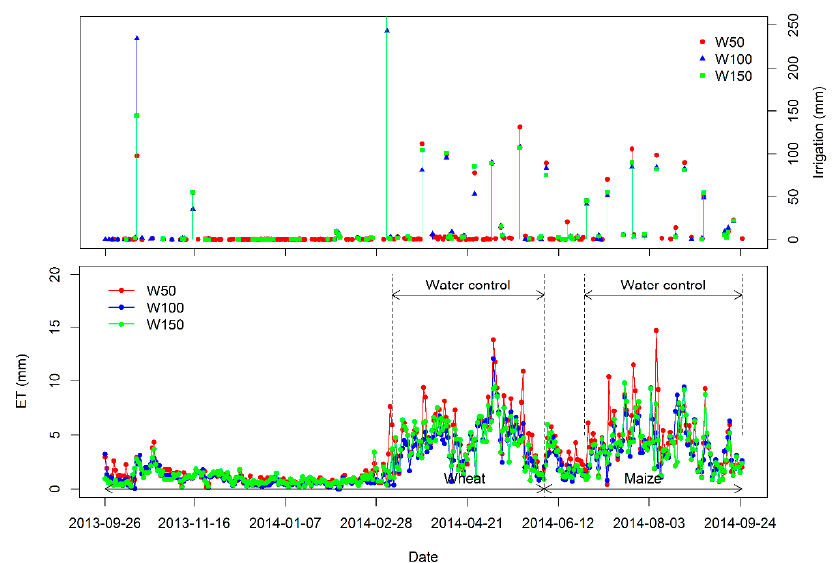
Figure 6. The irrigation and daily ET for the three water treatments applied in the lysimeter experiments during the wheat and maize seasons.